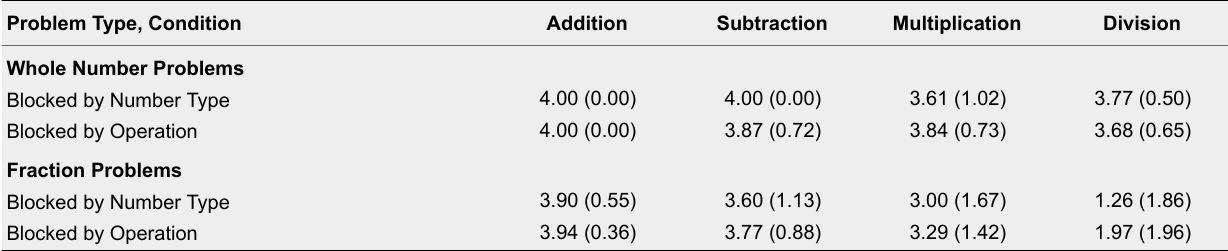
Average Number of Correctly Modeled Trials, out of 4, by